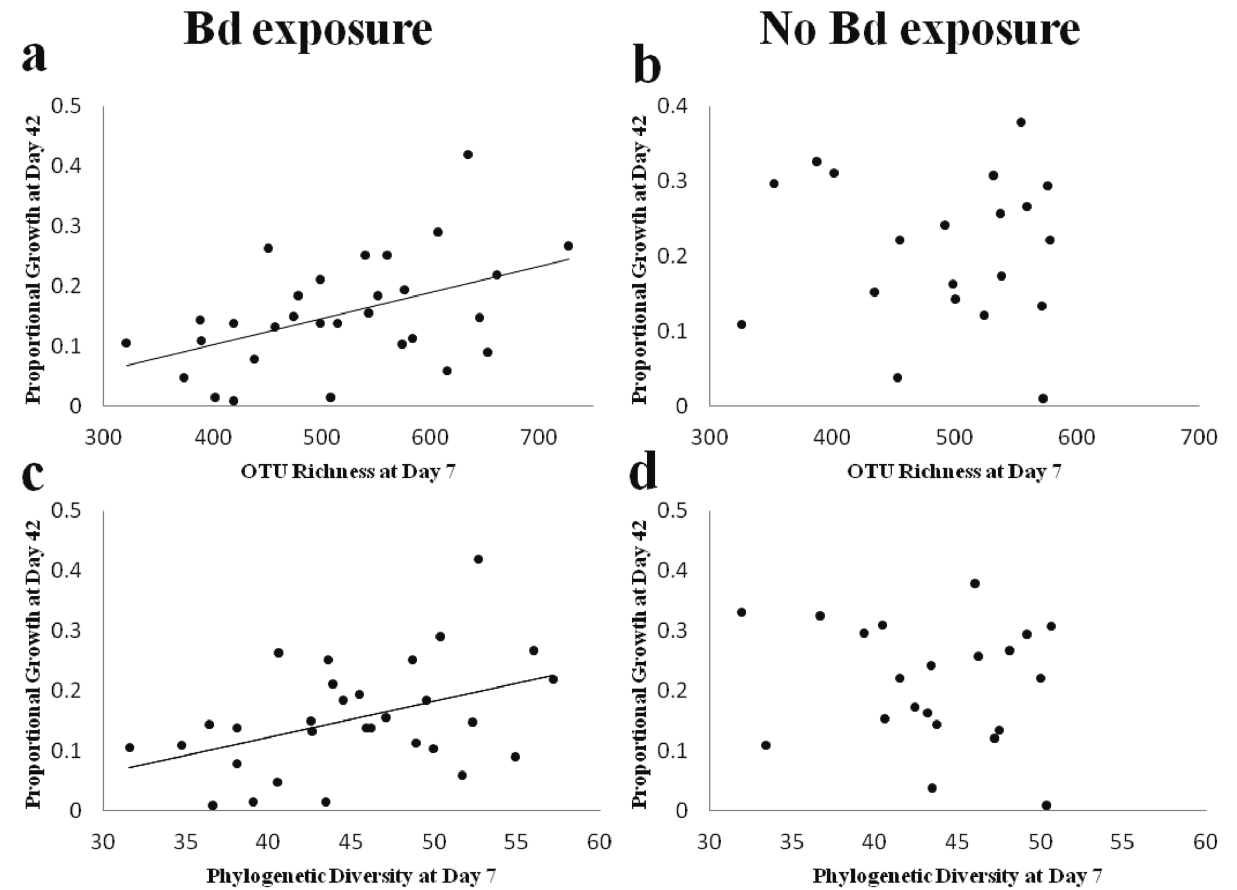
Fig 5. Correlations between OTU richness (a,b) or phylogenetic diversity (c,d) at day 7 and proportional growth at day 42, with (a,c) and without (b, d) exposure to